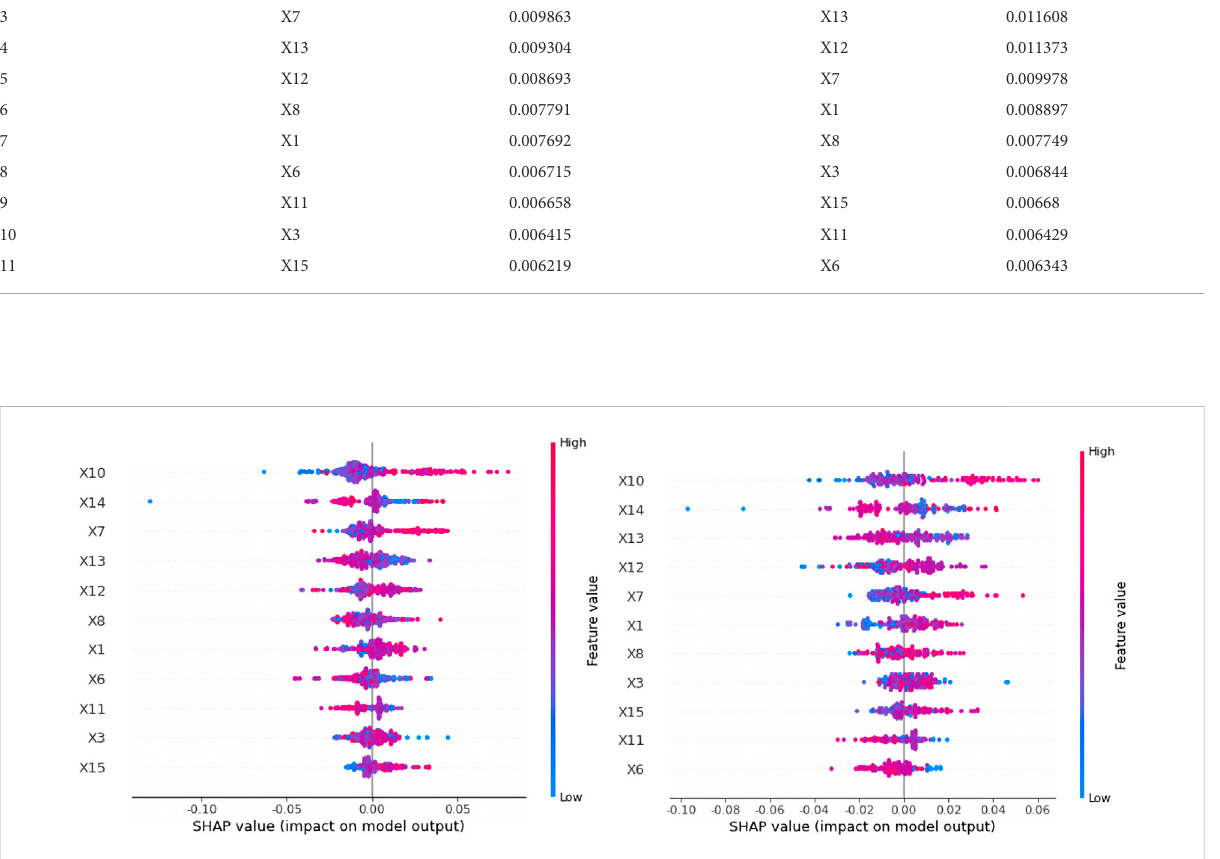
FIGURE 6 Training set (left) and test set (right) feature analysis graph.